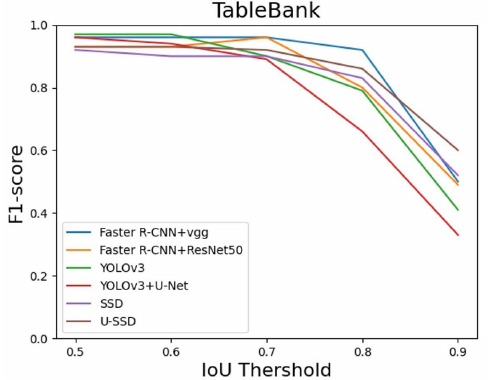
Figure 11. The F1-score from IoU = 0.5 to IoU = 0.9 on